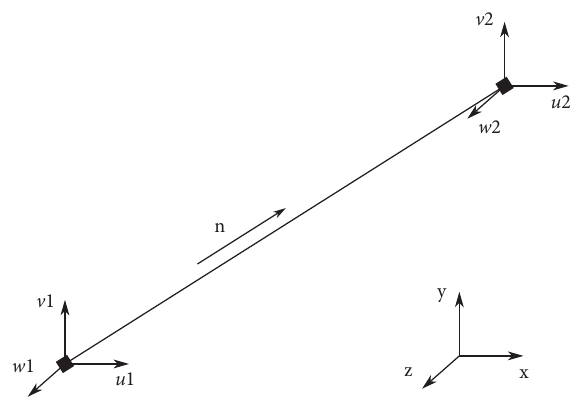
Figure 2: Linear truss element with nodal degrees of